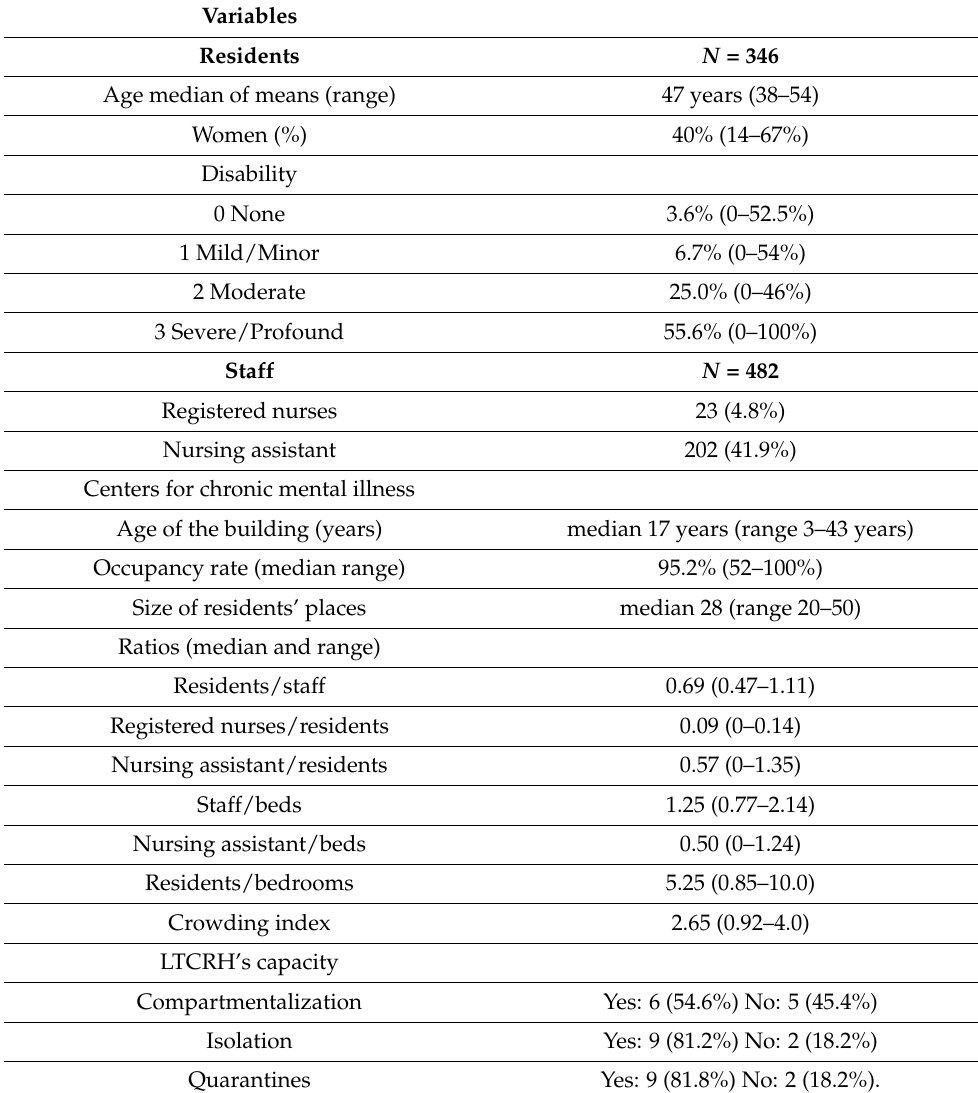
Table 1. Characteristics of long-term care residential homes (LTCRH) for patients with chronic mental illness (II). Health Departments 2 and 3 of Castellon. March 2020–January